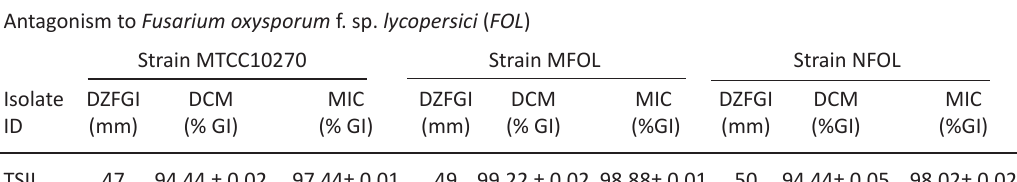
Table 1. Representation of antagonistic activity of marine actinobacteria to virulent strains of FOL Antagonism to Fusarium oxysporum f. sp. lycopersici ( FOL